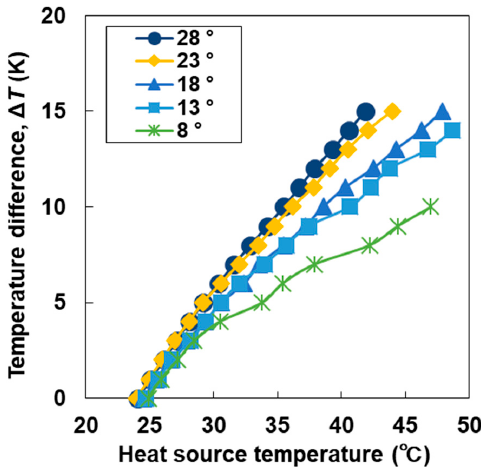
Figure 4. Temperature difference ( ∆ T ) of slope-type thin-film thermoelectric generators as a function of the heat source temperature.